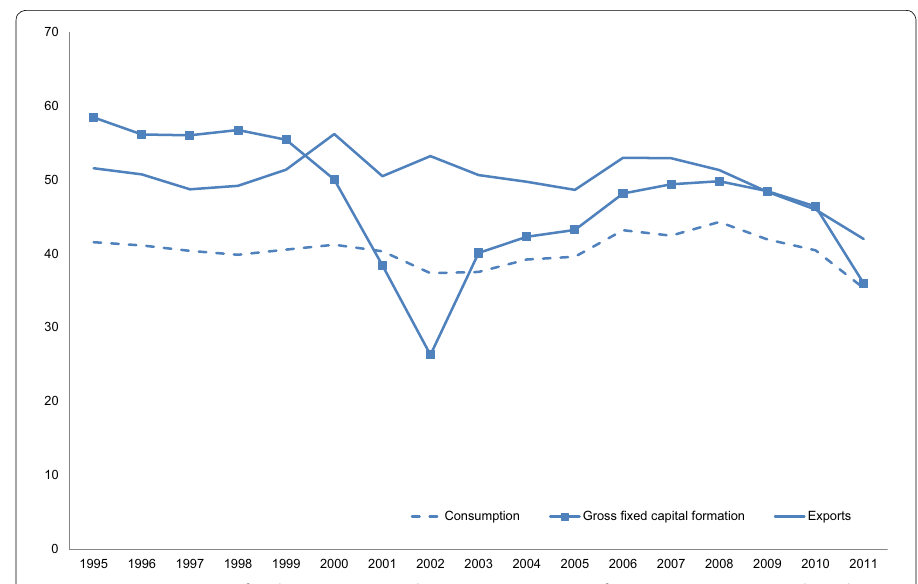
Fig. 1 Import intensities of Maltese GDP expenditure components (% of respective component) based on OECD input–output